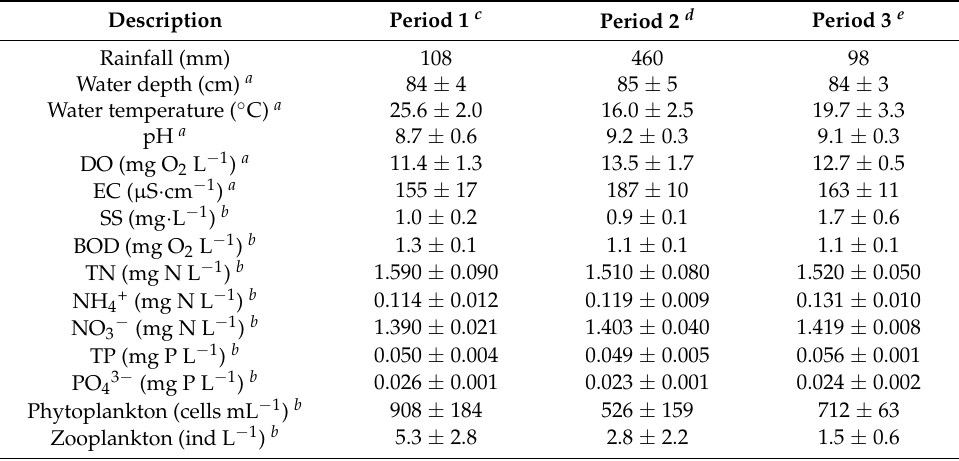
Table 2. Water quality changes in the large-scale mesocosm during the experimental